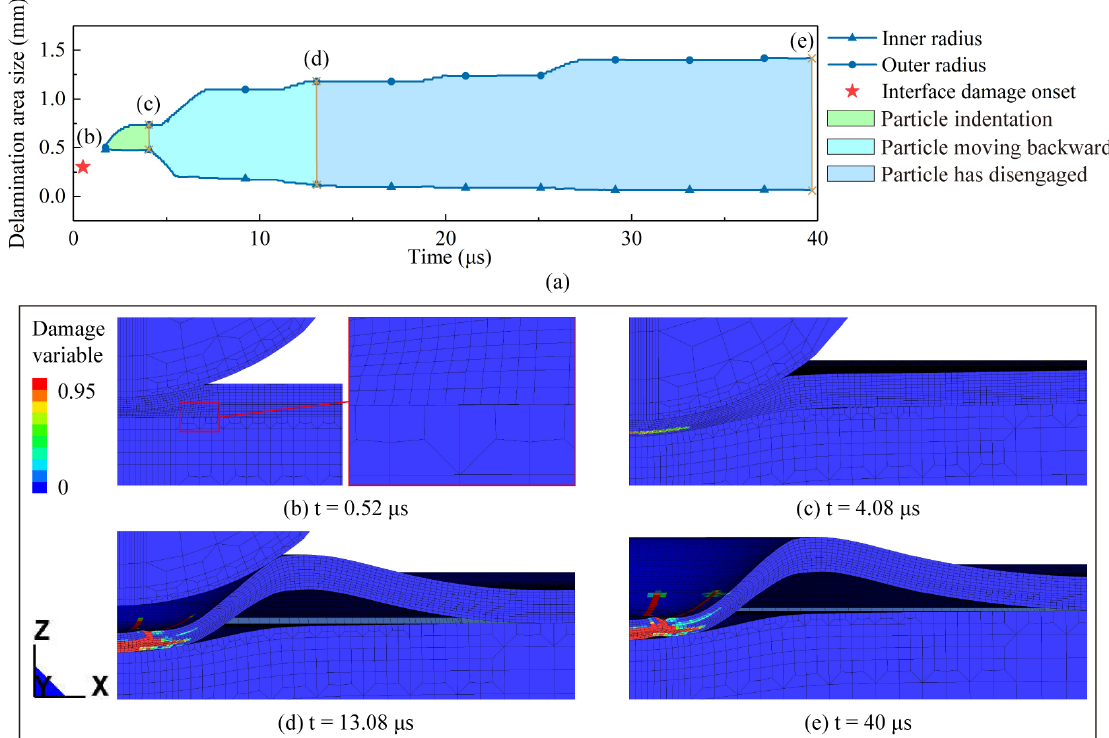
Figure 12. Interlaminar failure evolution of automotive coatings. ( a ) Histories of delamination area sizes. ( b – e ) Damage evolution: ( b ) 0.52 µ s, delamination onset. ( c ) 4.08 µ s, the particle reaches the lowest point. ( d ) 13.08 µ s, the particle disengages from the coating. ( e ) 40 µ s, the final state of interlaminar failure. The contour plot is displayed without interpolation of the damage variable.